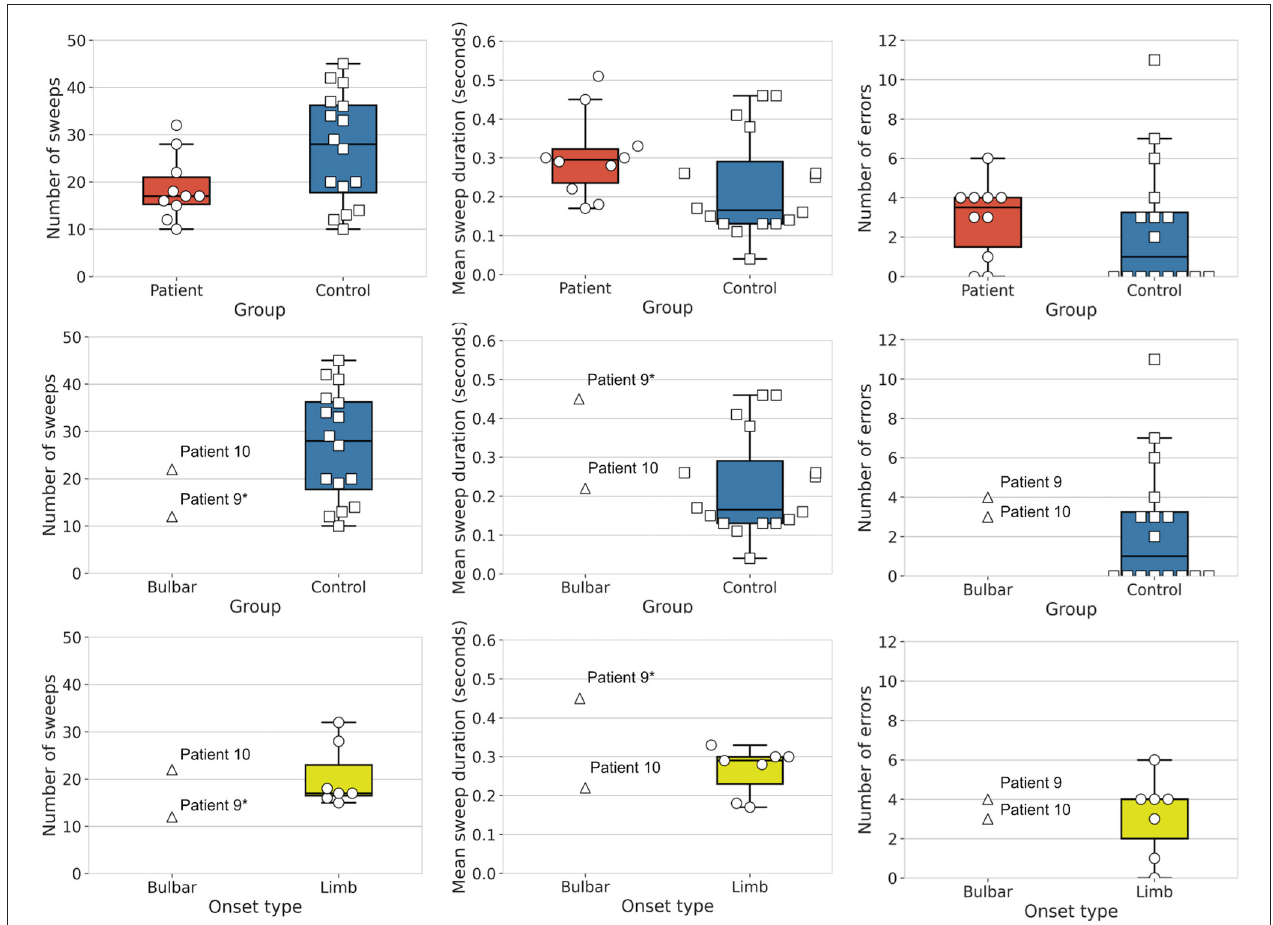
FIGURE 3 | Group differences in tongue movement features. Shown are mean number of sweeps, mean sweep duration and mean number of errors. Top row : Box plots show patients with amyotrophic lateral sclerosis (ALS) ( N = 10, circles, red) and healthy controls ( N = 16, squares, blue). Middle row : Box plots show bulbar-onset patients ( N = 2, triangles) and healthy controls ( N = 16, squares, blue). Bottom row : Box plots show bulbar-onset patients ( N = 2, triangles) and limb-onset patients ( N = 16, circles, yellow), where limb-onset patients with bulbar impairment are shaded circles (Individual patients marked * are significant when compared to the healthy controls or limb-onset